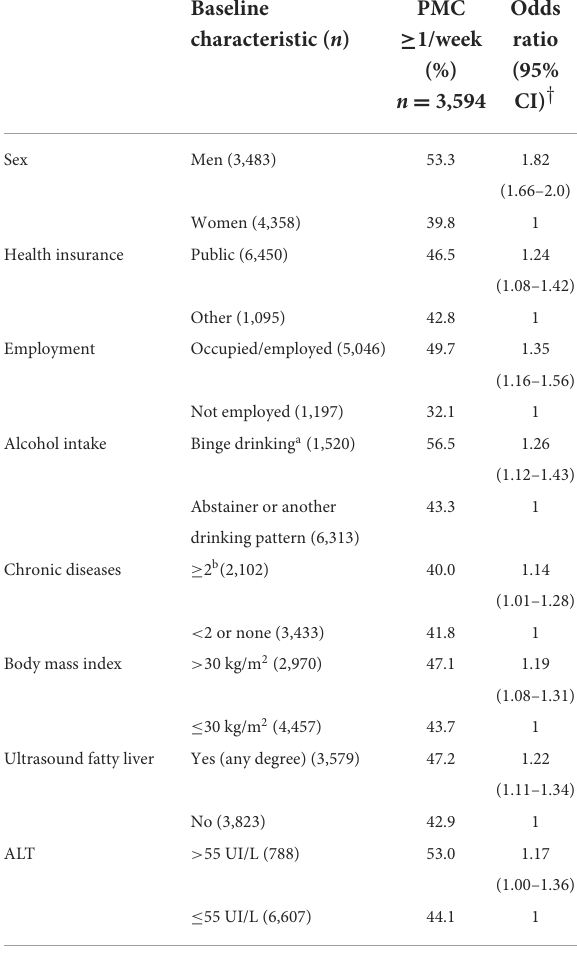
TABLE 2 Sociodemographic and health factors associated with processed meat consumption at least once a